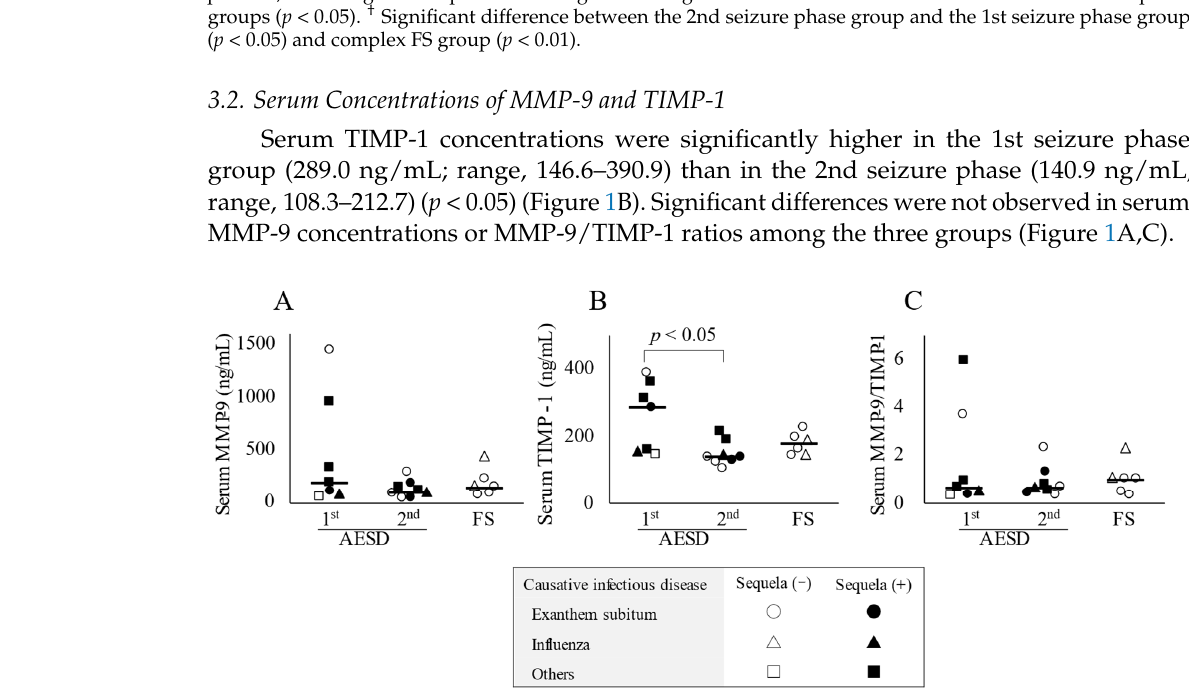
groups ( p < 0.05). † Significant difference between the 2nd seizure phase group and the 1st seizure phase group ( p < 0.05) and complex FS group ( p < 0.01).